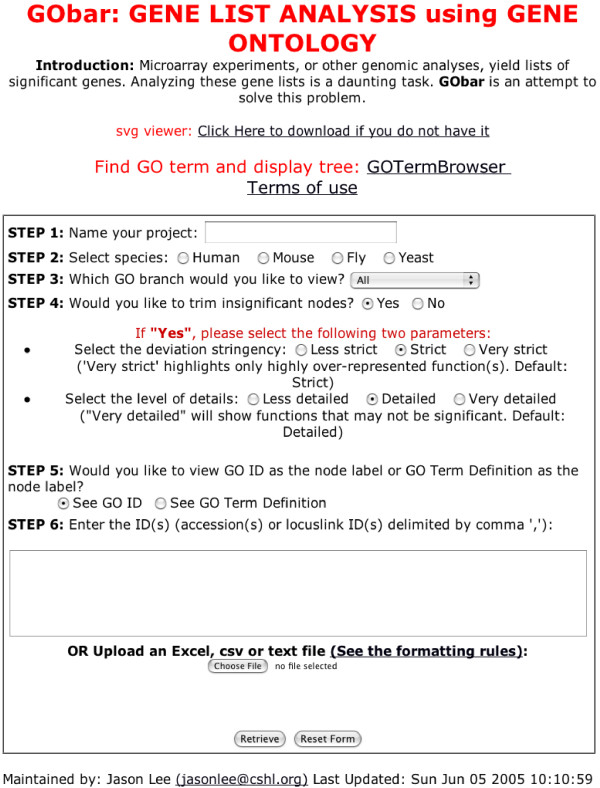
The front page of the GObar website. Selections are made for each step, and the list of genes is entered in the final step before launching the program. The pruning of the tree is controlled in step 4. A node can only be pruned if every node under it also satisfies the pruning condition. The pruning options are explained in the subsection pruning the tree. Very strict pruning might cause useful results to be thrown away, but can also highlight the best information in the dataset. In contrast, using a low stringency at this step, or no pruning, can cause too much information to be presented. Step 5 allows the nodes to be either annotated with GO ids (preferred for large trees) or definitions of GO terms. The GOTermBrowser link at the top of the page allows search for GOids using keywords or regular expressions such as "*NA*binding" to explore the GO tree neighborhood of the search term.